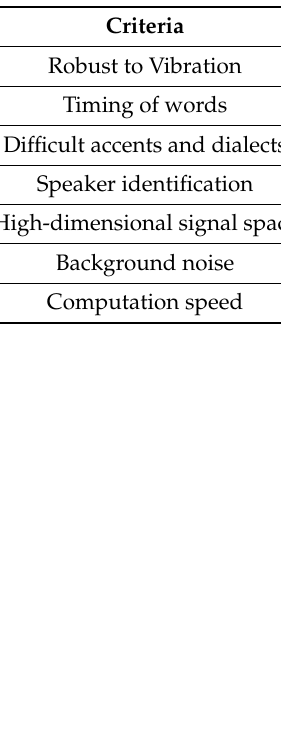
Table 7. Review of speech feature detection and extraction performance using various features.